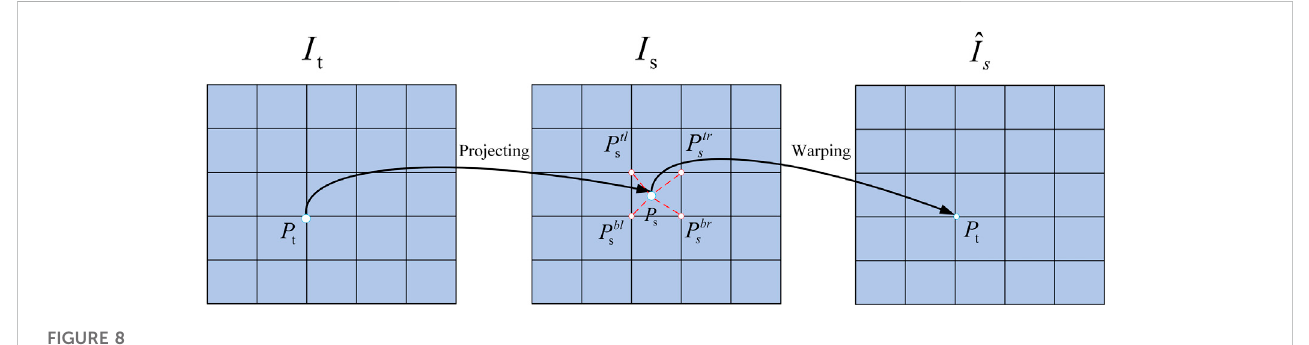
FIGURE 8 Differentiable image warping